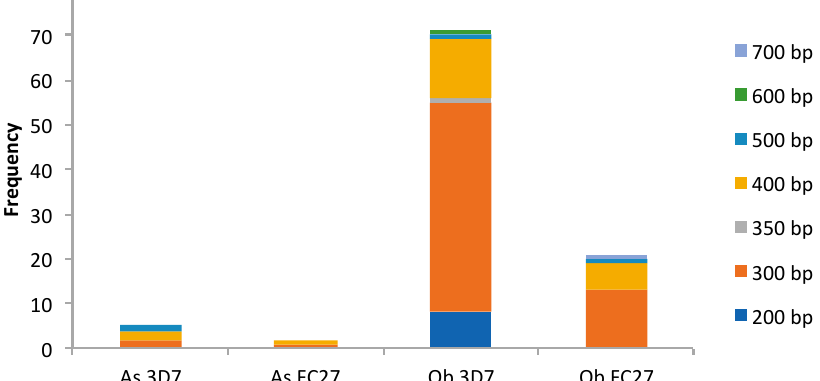
Figure 2. Msp2 gene diversity . As, Asutsuare; Ob, Obom; FC27 and 3D7 are the two Msp2 allelic families. Each color (dark blue (200 bp), orange (300 bp), gray (350 bp), honey (400 bp), light blue (500 bp), green (600 bp) and periwinkle (700 bp)) represents a fragment size (bp), irrespective of the allelic group.